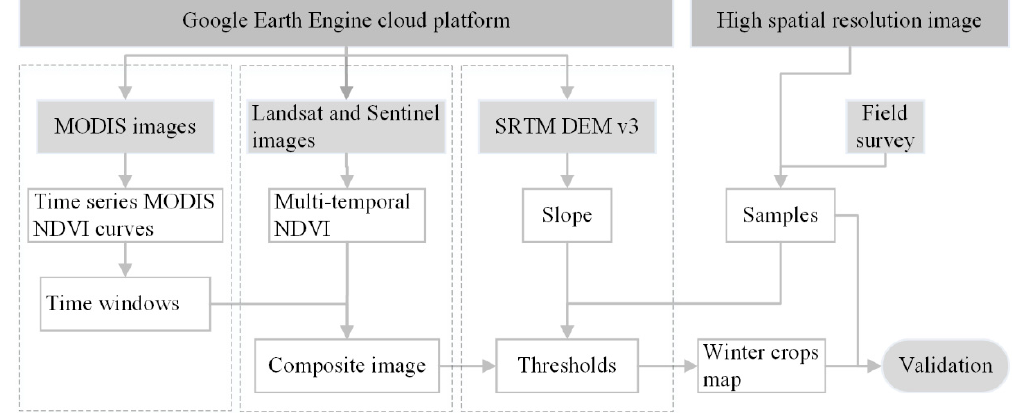
Figure 2. Workflow of the phenology and pixel-based winter crop mapping in this study.